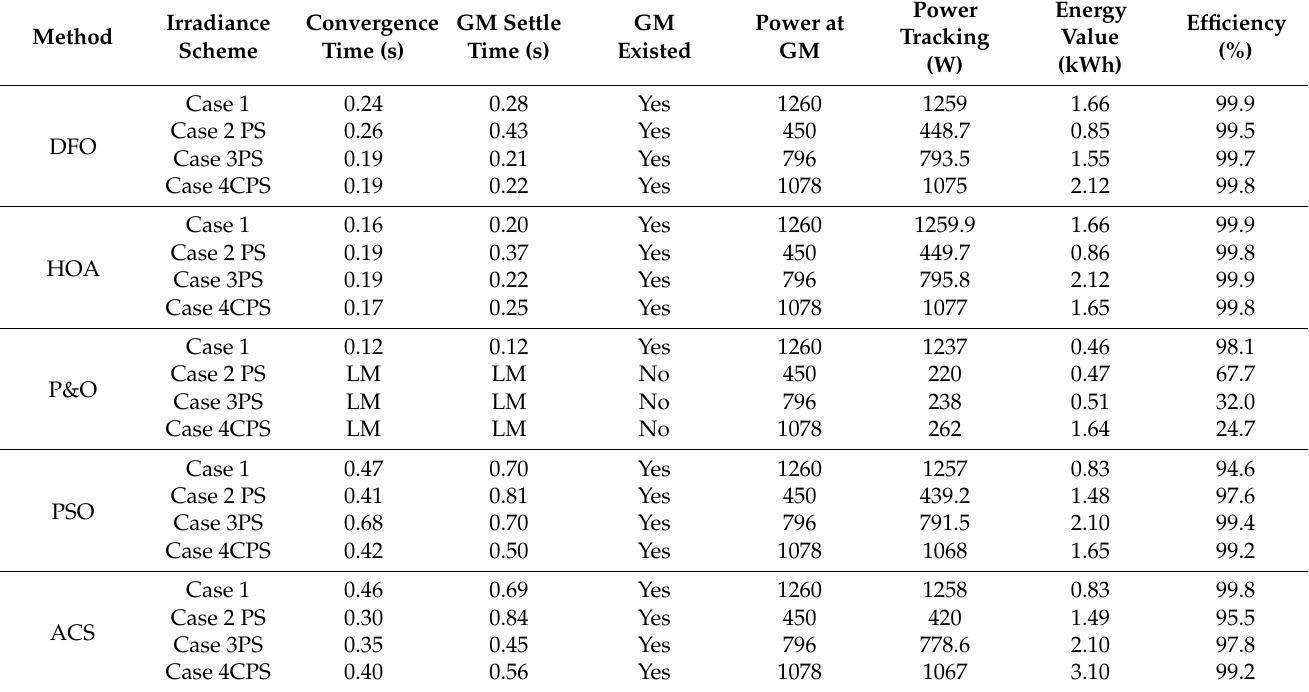
Table 1. Techniques for comparing the power, tracking, and efficiency with that of the